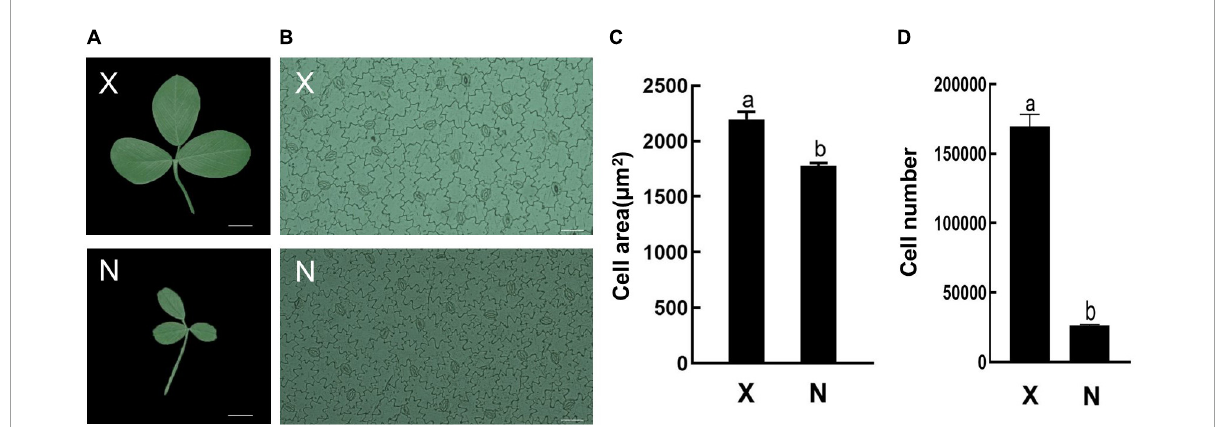
FIGURE7 Leaf morphology and lower epidermal cells observed under microscope. (A) Morphological observation of large (X, “Xinjiang Daye”) and small (N, “Nei 1 × Nei 2”) leaves. Scale bar, 1 cm. (B) Epidermal cells of large (X, “Xinjiang Daye”) and small (N, “Nei 1 × Nei 2”) leaves under microscope. Scale bar, 50 µ m. (C) The average area of a single epidermal cell in the leaf of “Xinjiang Daye” and “Nei 1 × Nei 2”. (D) Estimates of the average total cells number in a single leaf of “Xinjiang Daye” and “Nei 1 × Nei 2”. The letters (a, b) indicate the significant difference at P < 0.05 by Student’s t -test. The L4 stage leaves were used for the observation.